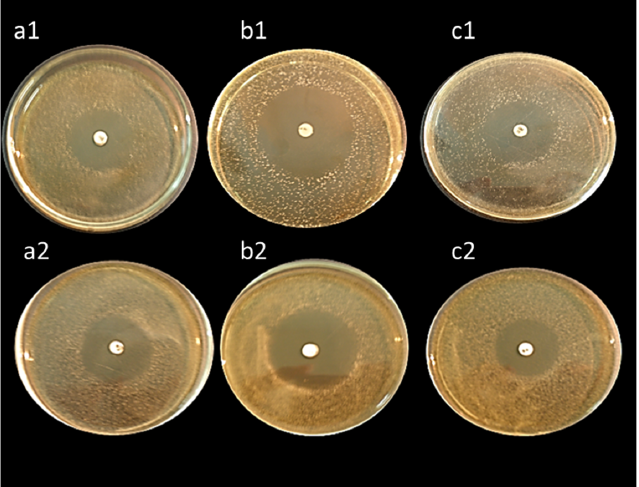
cording to CLSI standards. Figure 6. Antibacterial activity of cell-free supernatants of L. delbrueckii ASO100 (upper three plates) and L. rhamnosus ASO20 (lower three plates) against Bacillus subtilis ( a1 , a2 ), Staphylococcus aureus ( b1 , b2 ), and Escherichia coli ( c1 , c2 ). The plates were firstly inoculated with the tested pathogenic bacteria, then allowed to air dry for 15 min; discs impregnated with cell-free supernatants were spotted on the middle of the plates. Diameters of the formed inhibition zones were measured after incubation at 37 °C for 24 h.